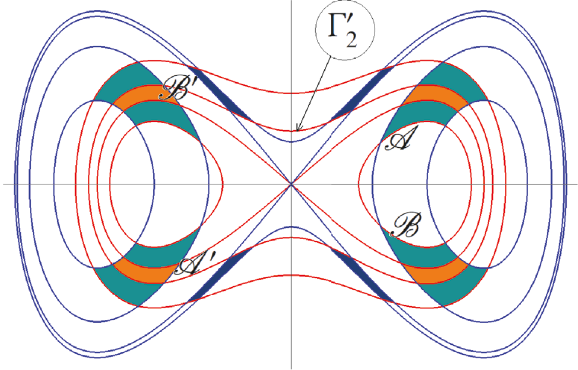
Figure 7: The present figure shows some possible rectangular regions which can be considered for the application of Theorem